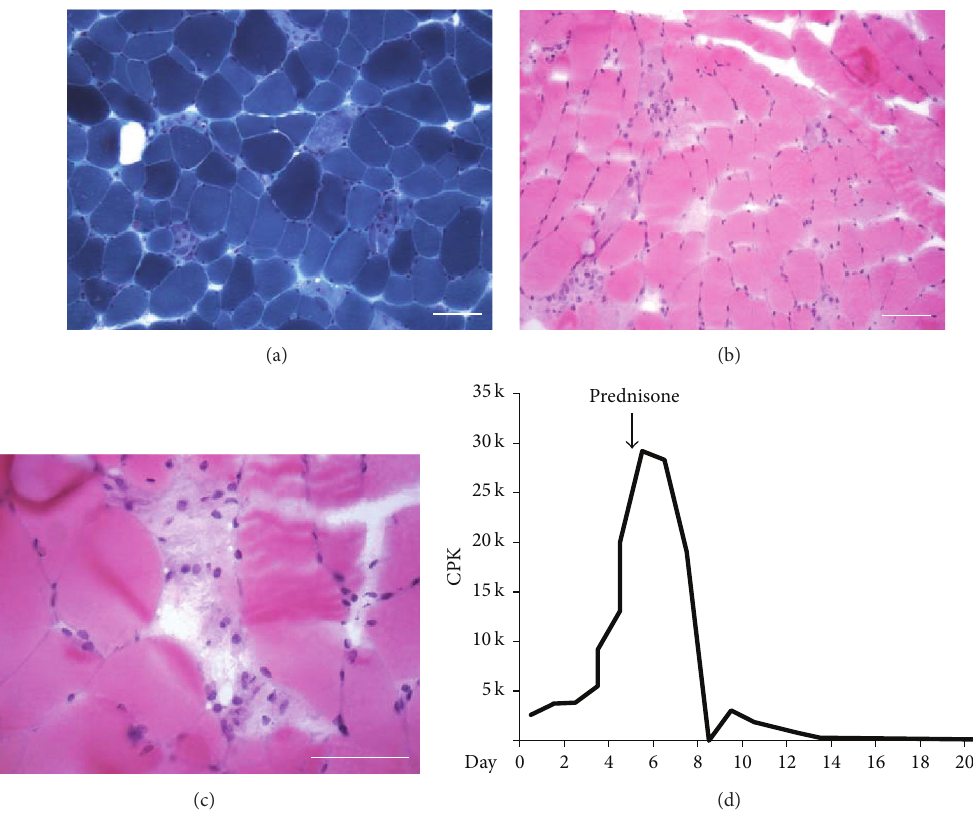
Figure 1: Necrotizing myositis from biopsy of the left quadriceps muscle. (a) Gomori trichrome stain showing pale focal necrosis without evidence of ragged red fibers, nemaline rods, inclusions, or increased interstitial fibrosis. 20x objective. Scale bar 100 𝜇 m. (b) Haematoxylin and eosin stain showing focal necrosis without abundance of inflammatory hematopoietic cells. 200x. Scale bar 100 𝜇 m. (c) Highlight of area of focal necrosis in haematoxylin and eosin. 400x. Scale bar 100 𝜇 m. (d) Time-course of CPK elevation during hospitalization. Day 0 indicates day of